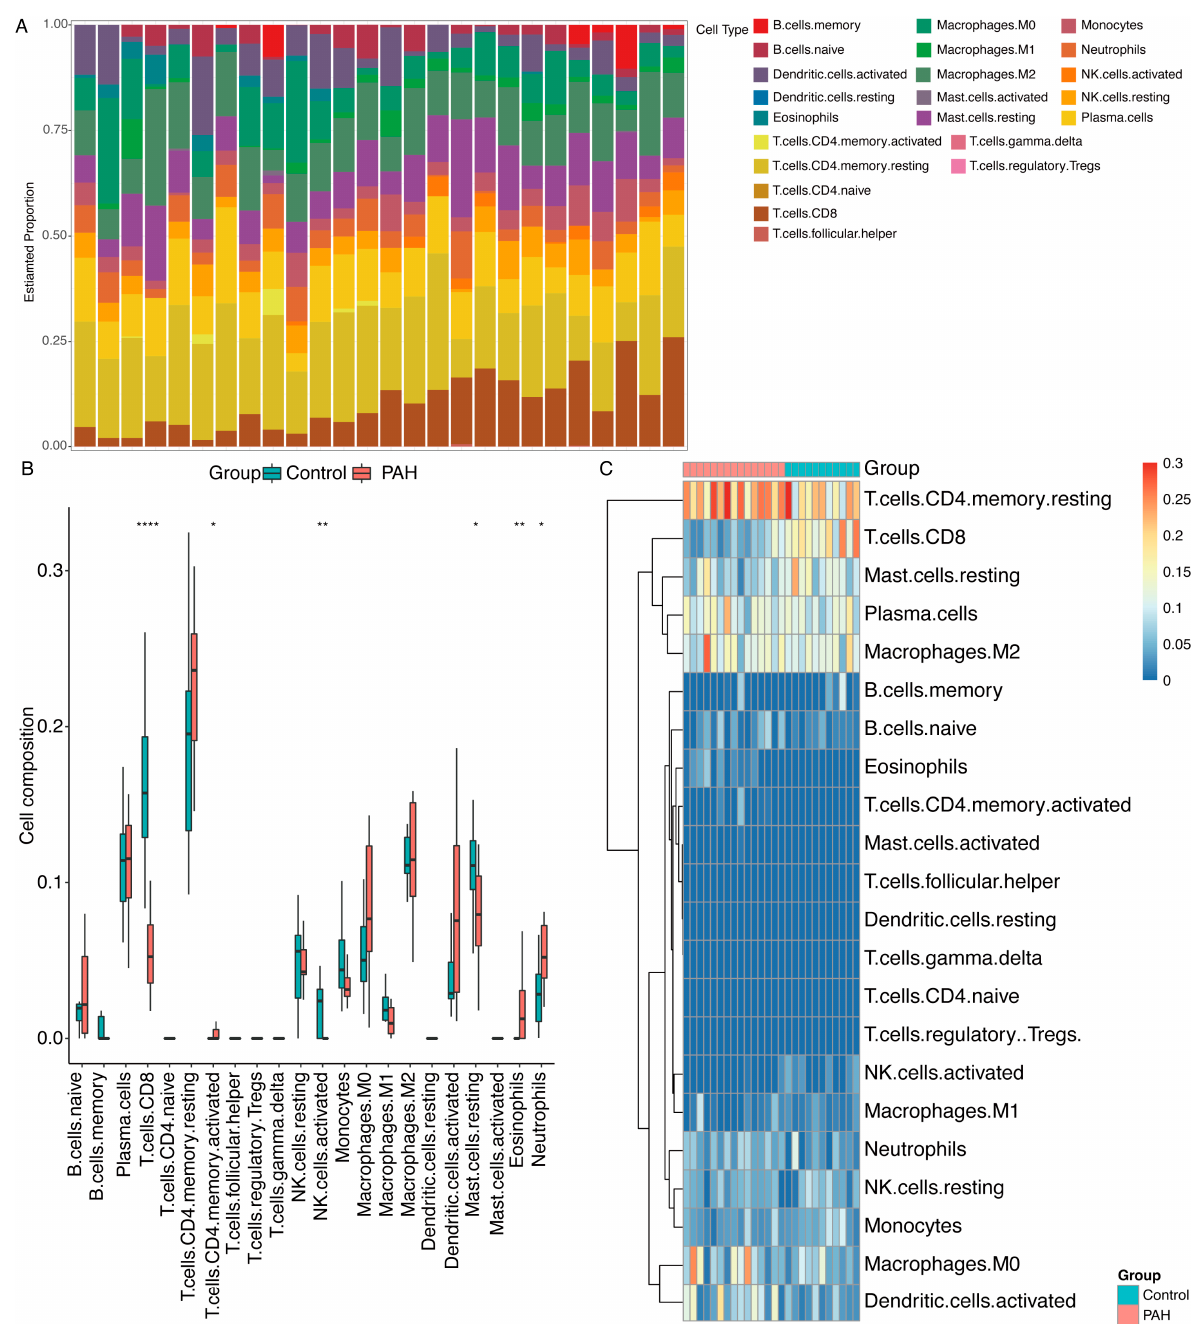
Figure 7. Immune cell infiltration in PAH and control lung tissues in the GSE113439 dataset. ( A ) The composition of 22 kinds of immune cells in each sample by histogram. ( B ) The composition of 22 kinds of immune cells in each sample by heatmap. ( C ) Comparison of 22 immune cell subtypes between patients in PAH and controls. Blue and red colors on behalf of control and PAH samples, respectively. * p value < 0.05, ** p value < 0.01, **** p value <